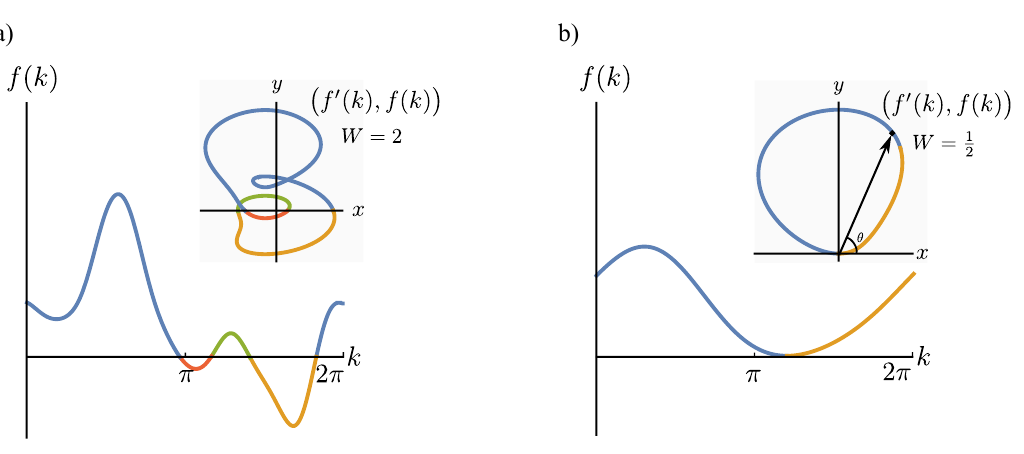
Figure 1: Relationship between the nodes of f ( k ) and the winding number W of the (cid:0) (cid:1) f (cid:48) ( k ) , f ( k ) planar curve α ( k ) =